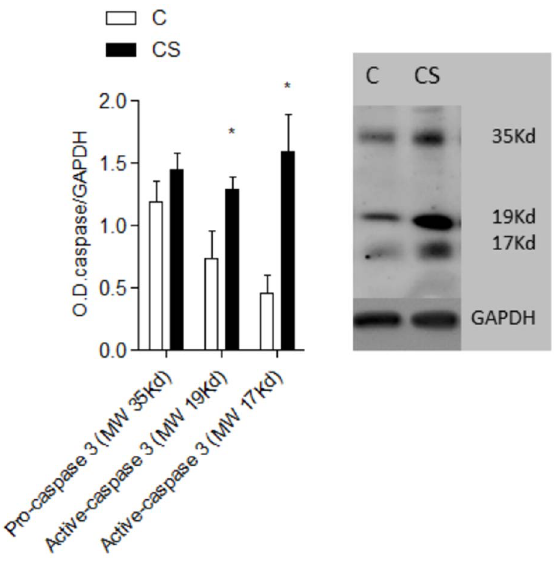
Figure 4. Apoptosis. C: control group; CS: cigarette smoke group; O.D.: optical density; GAPDH: glyceraldehyde-3-phosphate dehydrogenase; MW: molecular weight. Upper-bands: pro-Caspase and active Caspase subunits; lower bands: GAPDH; pro-Caspase/GAPDH C vs. CS p 5 0.2; active-Caspase 3 (MW 19 kD) C vs. CS p 5 0.04; active-Caspase 3 (MW 17 kD) p 5